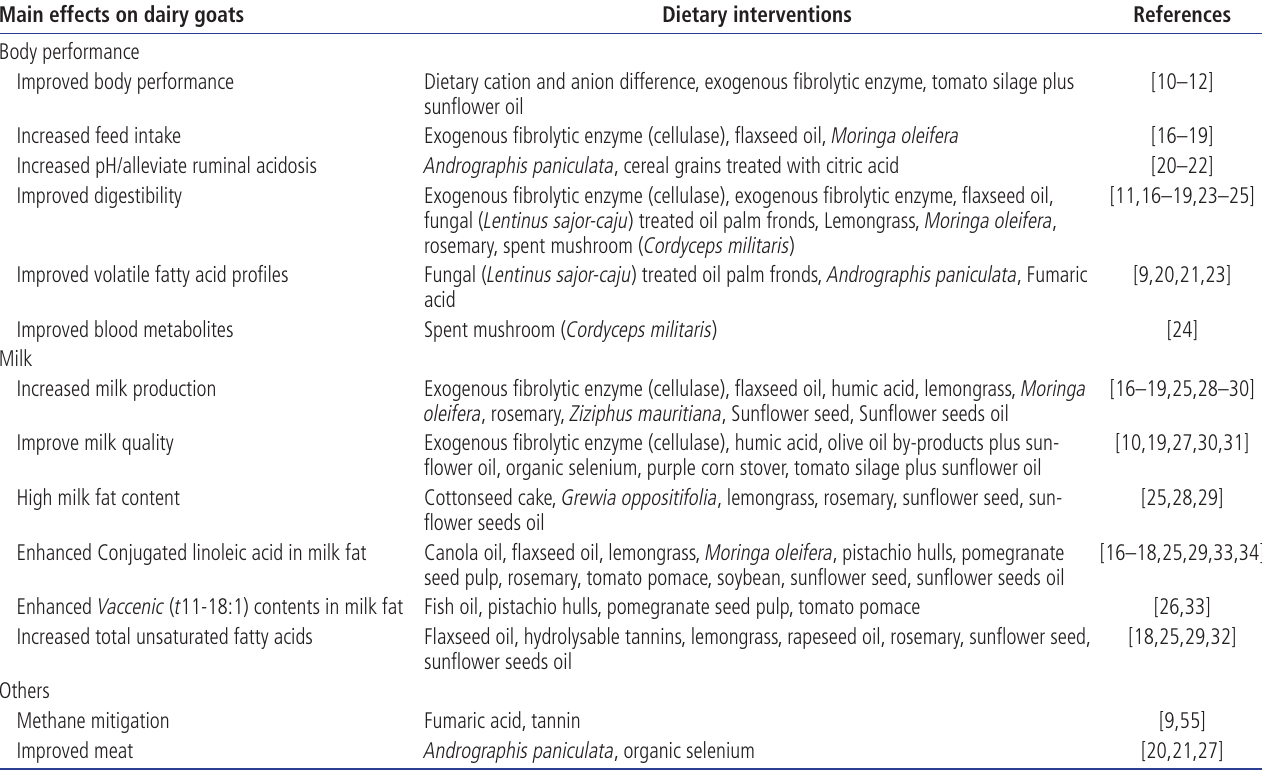
Table 1. List of recent dietary interventions and their main effects on dairy goats Main effects on dairy goats Dietary